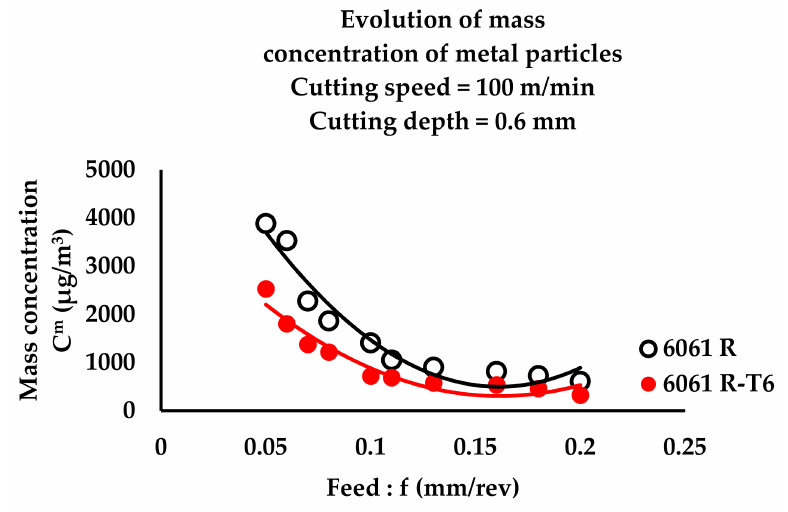
Figure 8. Evolution of the mass concentration of metal particles as a function of the feed during dry machining of recycled alloys 6061 R and 6061R-T6.